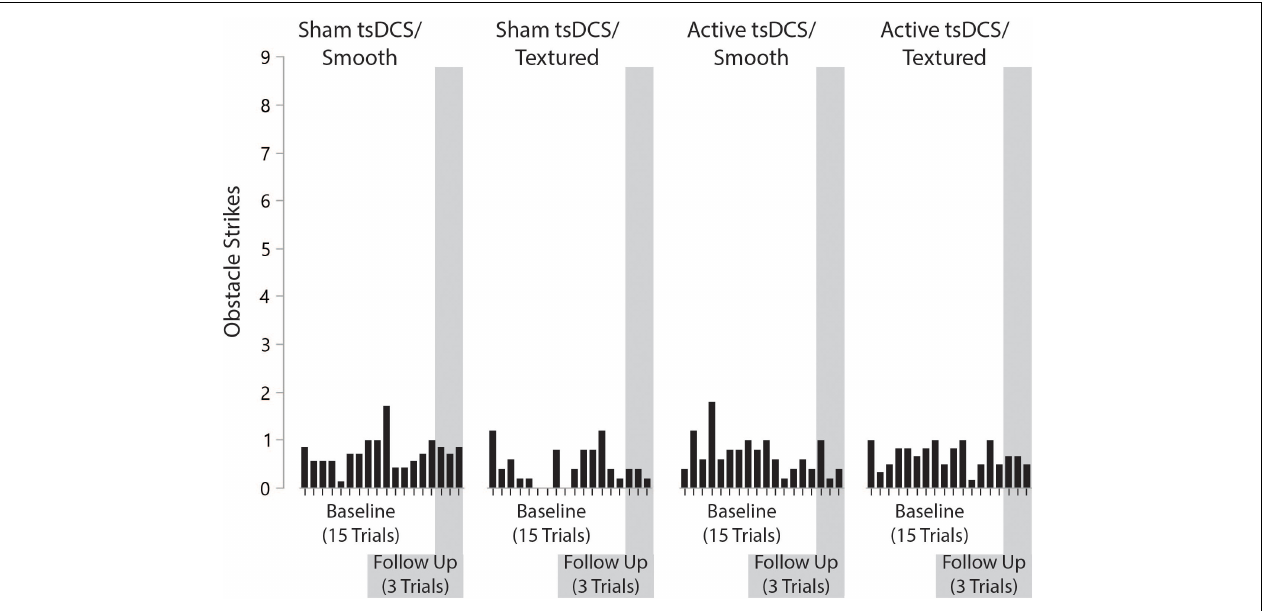
FIGURE 6 | Number of obstacle strikes by group, trial number, and visit. On average, there was approximately one obstacle strike (out of nine obstacles) per walking trial. The number of obstacle strikes across visits was consistent.